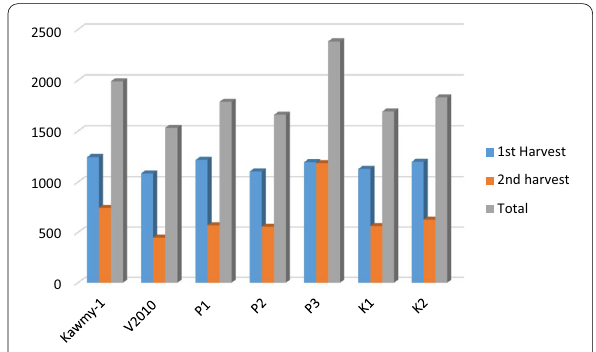
Fig. 2 Effect of variety, P and K fertilizer on Mungbean seed yield (kg ha − 1 ), combined mean of 2018 and 2019